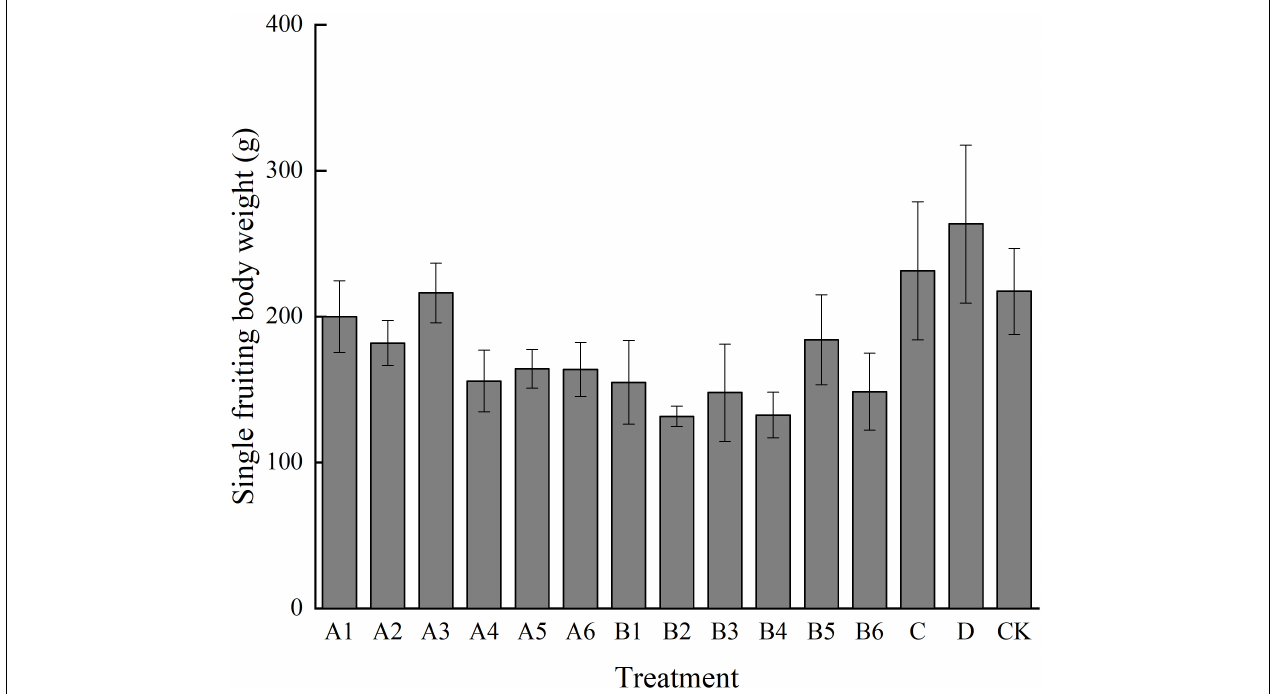
FIGURE 1 | Effects of different treatments on the weight of single fruiting bodies. Different letters in the figure indicate significant differences ( P < 0.05).